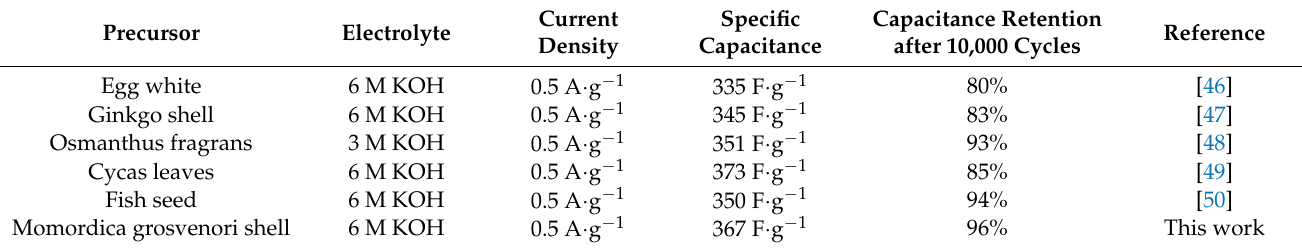
Figure 5. Electrochemical performance: ( a ) CV curves of MGCs at a scan rate of 100 mV ∙ s − 1 ; ( b ) CV curves of MGCs-2 at different scan rates; ( c ) GCD curves of MGCs at a current density of 0.5 A ∙ g − 1 ; ( d ) GCD curves of MGCs-2 at different current densities; ( e ) specific capacitances at various current densities of MGCs; ( f ) cycling stability at 5 A ∙ g − 1 of MGCs-2. Table 2. Comparison of the electrochemical properties of various reported biomass-derived carbon materials.